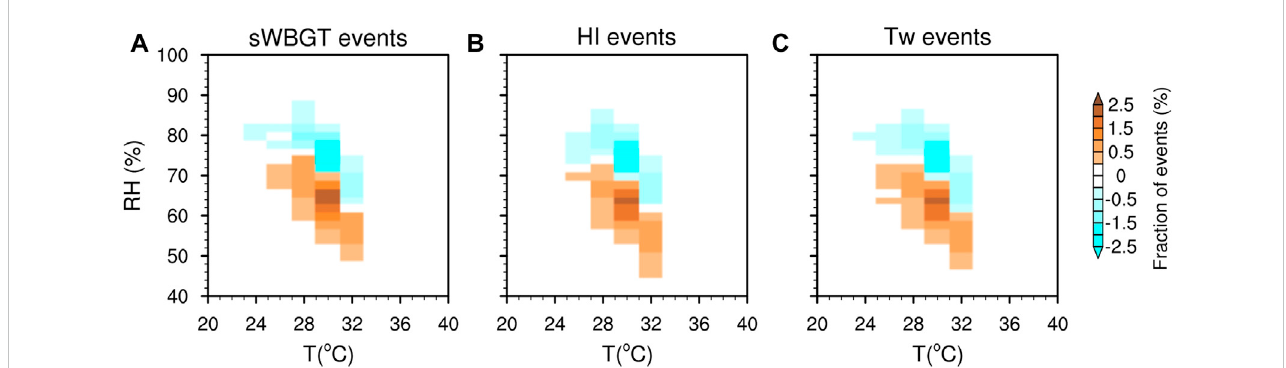
FIGURE 5 Thedifference(homogenizedminusnon-homogenized)inthebivariatejointdistribution ofTandRHwhich producethreetypeextremeevents (A-C) of corresponding indicators. Temperature and humidity are fi rstly binned by 2 ° C and 2% intervals, and the fraction of extreme-producing (all cases during the study period across the domain) T-RH con fi gurations that fall into corresponding bivariate bins are calculated and